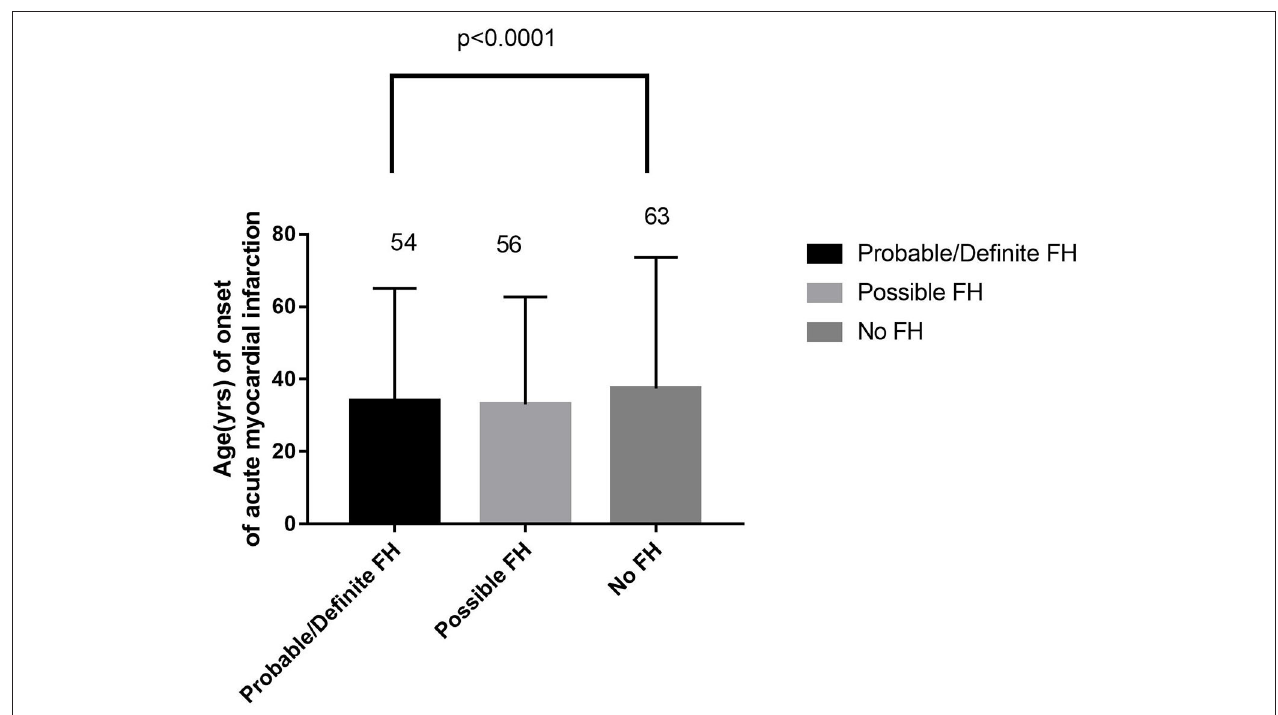
FIGURE 2 | Comparison about age of onset of acute myocardial infarction in probable/definite HeFH, possible HeFH, and non-HeFH.